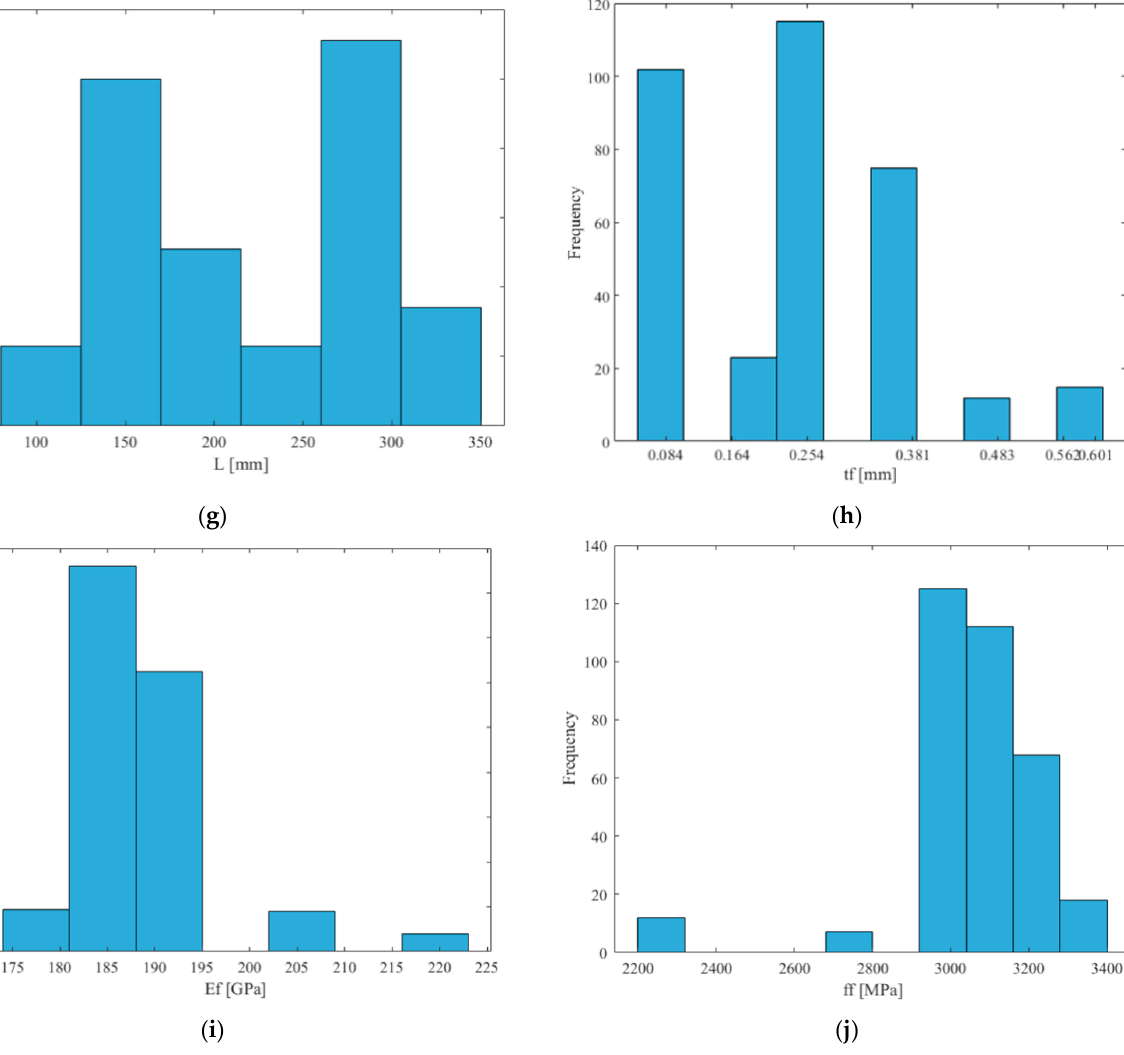
Figure 1. Input parameters: ( a ) sample width— b ; ( b ) concrete compressive strength— f c ; ( c ) sample thickness— t c ; ( d ) concrete tensile strength— f ct ; ( e ) concrete modulus of elasticity— E c ; ( f ) SRP tape width— b f ; ( g ) anchorage length— L ; ( h ) SRP tape thickness— t f ; ( i ) SRP modulus of elasticity— E f